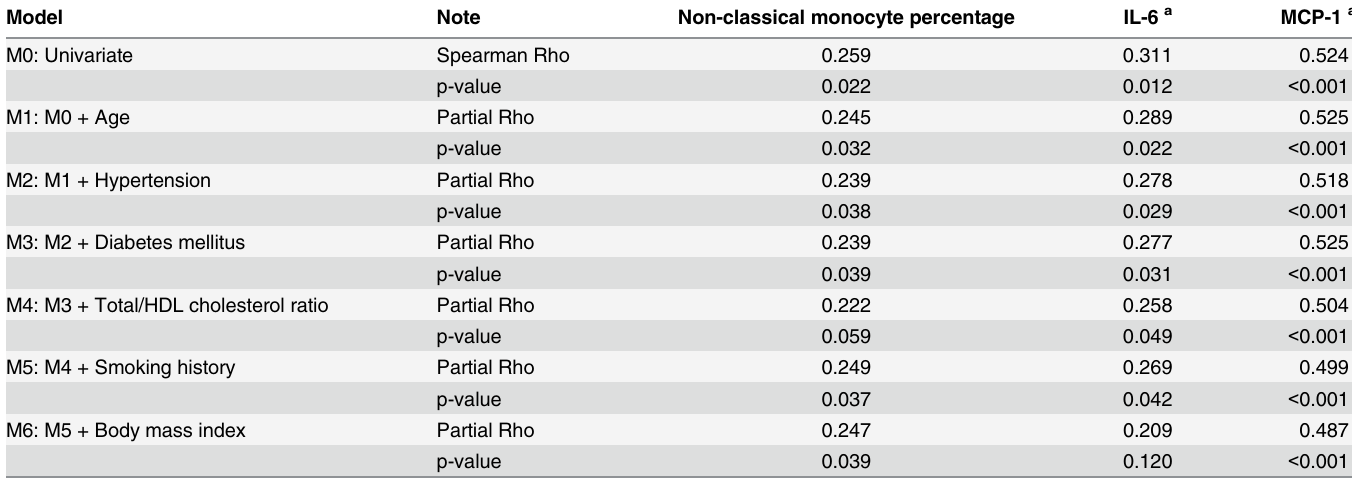
Table 3. Adjusted Spearman ’ s correlation for 2-year coronary artery calcium (CAC) Agatston score progression.